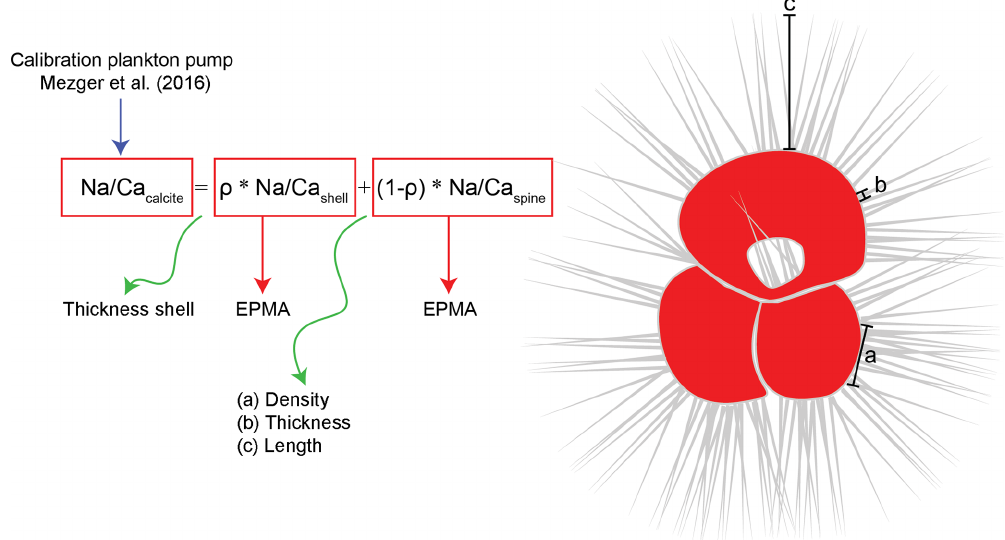
Figure 8. General mass balance model combining the relative contribution ( ρ ) of spine (Na / Ca spine ) and shell calcite (Na / Ca shell ) Na / Ca values to explain the whole-shell (Na / Ca calcite ) Na / Ca values measured. The relative contribution of shell calcite depends on the shell thickness relative to the number of spines, whereas the relative contribution of spines depends on spine density, thickness and length. The Na composition of the individual shell parts was measured with EPMA, and the total shell Na / Ca values are derived from laser ablation measurements on specimens still containing shell and spines (Mezger et al., 2019). Spines could be up to 2–3mm long and are therefore not shown in their true scale in this